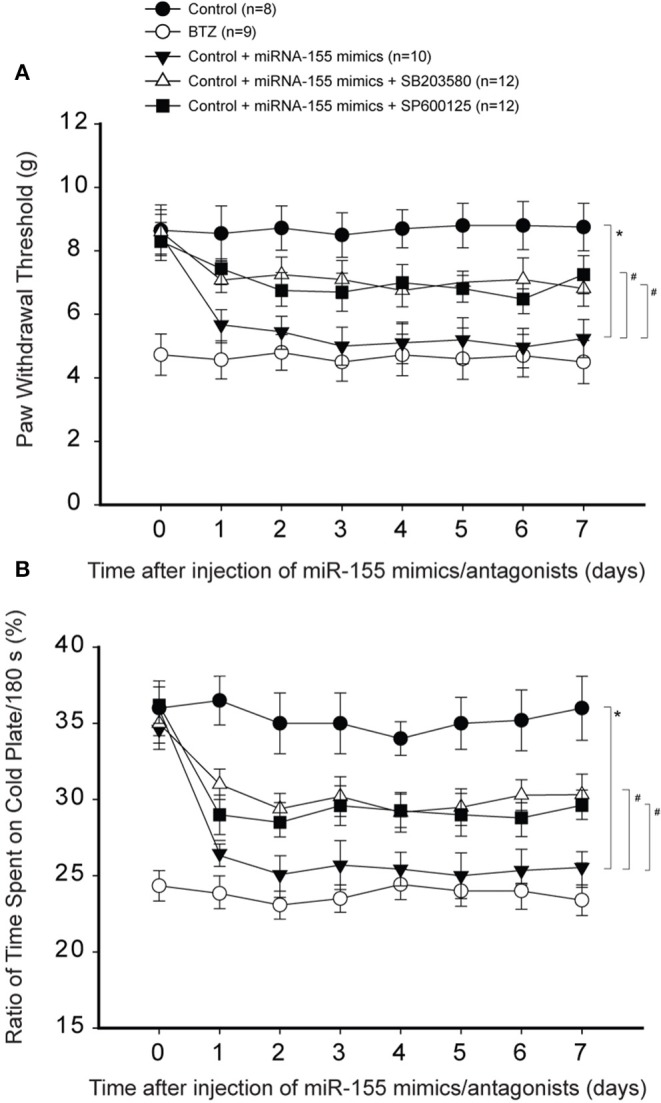
Effects of blocking p38-MAPK and JNK signal on mechanical and cold sensitivity. Intrathecal injection of SB203580 (5 μg each day over three consecutive days) and SP600125 (5 μg each day over three consecutive days) were performed to inhibit p38-MAPK and JNK signal pathway. (A,B) As compared with controls, intrathecal injection of miR-155 mimics (3 μg each day over three consecutive days) significantly decreased PWT and % time spent on the cold plate. With respective SB203580 and SP600125, decreased PWT and % time spent on the cold plate by miR-155 mimics were largely restored. *P < 0.05, control rats vs. control rats with mimics; #P < 0.05, rats with mimics vs. rats with mimics plus SB203580 or mimics plus SP600125. The number of rats in each group was shown on the figure.